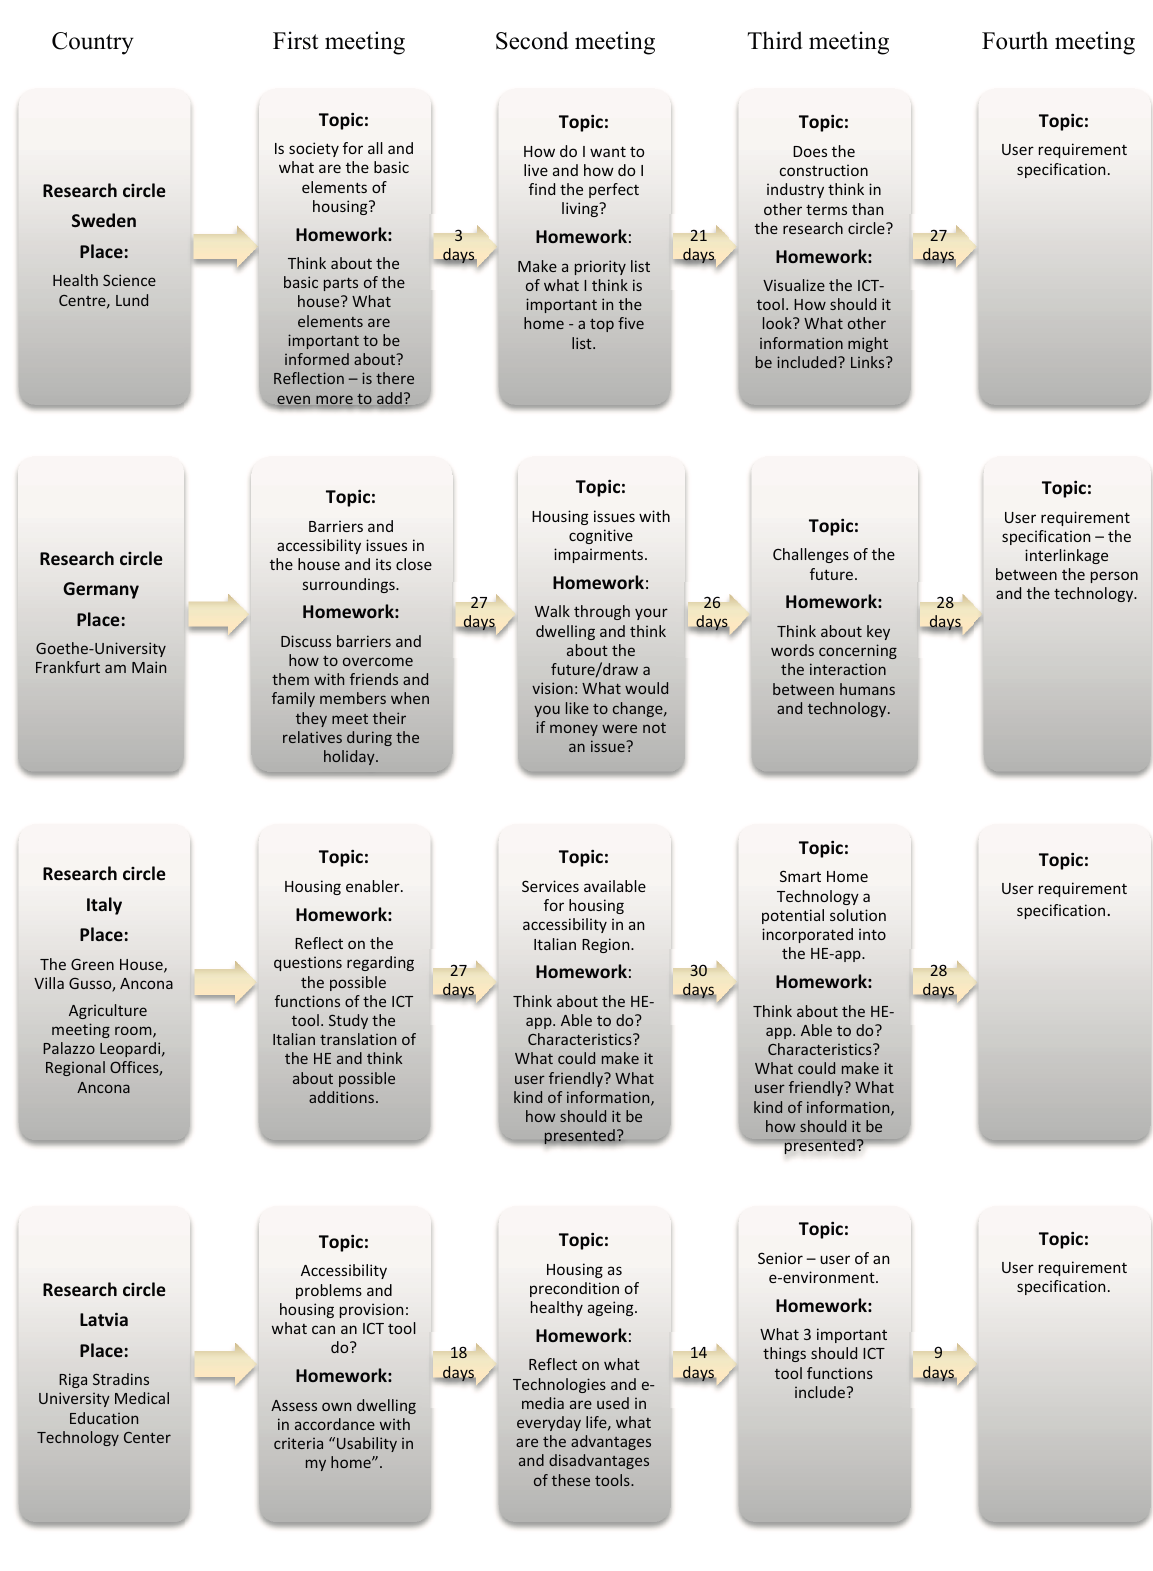
Figure 1. Topics discussed and homework assignments in each country decided by each research circle from meeting to meeting. In Italy it was the same homework assignment between meetings two and